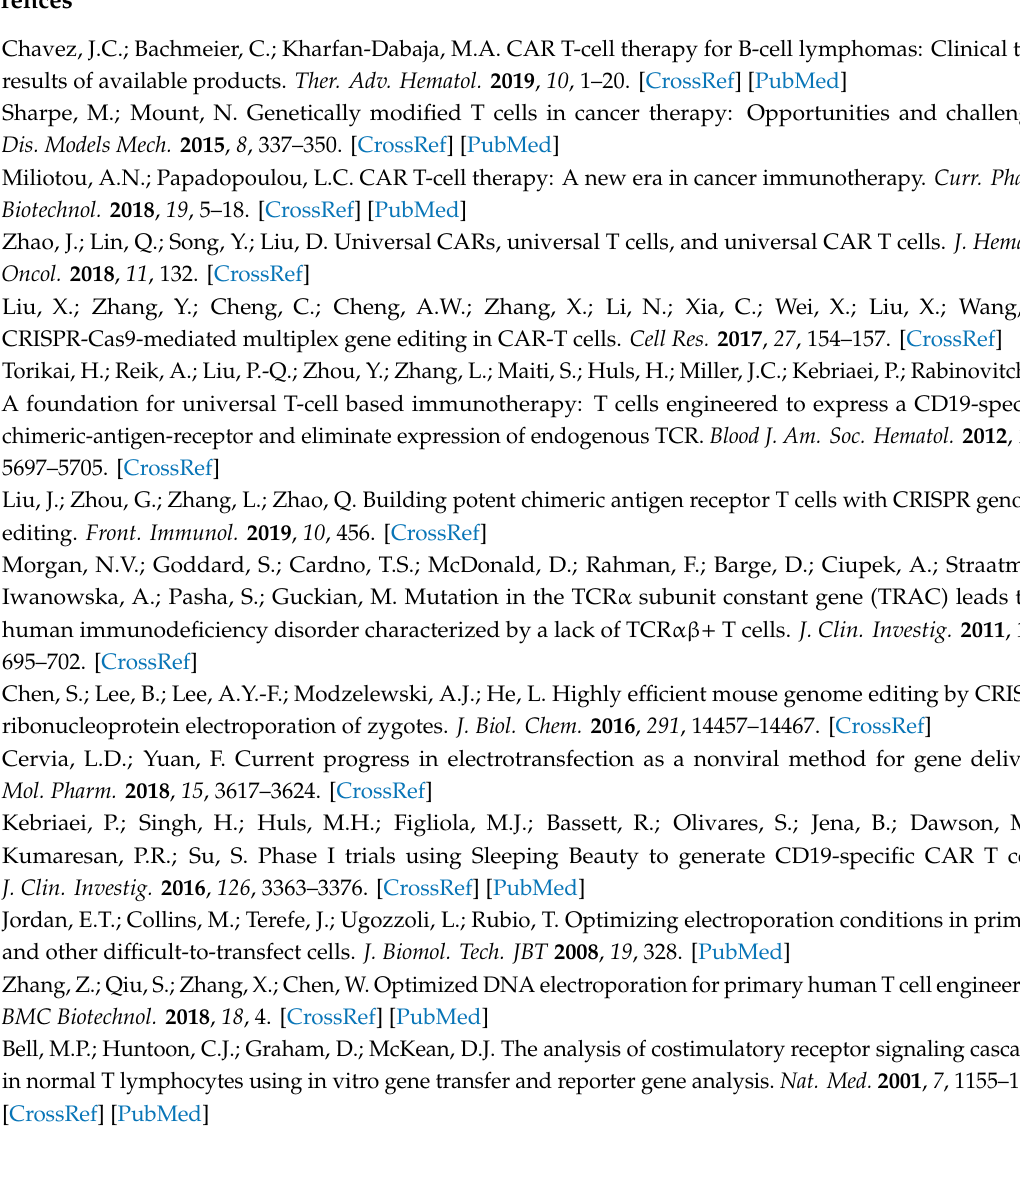
Figure 6A. NIH / 3T3 cells were treated with either non-targeting control siRNA (Ctrl siRNA) or procaspase 3 siRNA (CASP3 siRNA). A. image of the whole membrane; B. membrane portion containing the GAPDH bands; C. membrane portion containing the procaspase 3 bands. Lane 1&5: Cells treated with Ctrl siRNA (sample 1); Lane 2&6: Cells treated with CASP3 siRNA (sample 1); Lane 3&7: Cells treated with Ctrl siRNA (sample 2); incubated with procaspase 3 antibody, and lane 5–8 were incubated with GAPDH antibody. The bands of the two samples were similar to each other. Thus, only the bands of sample 2 were reported in Figure